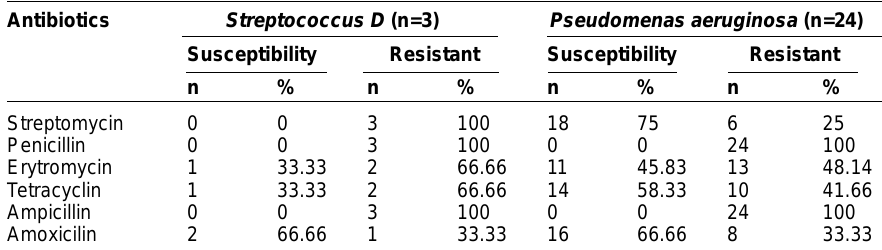
Table-1 (d): Antibiotic susceptibility of bacterial isolates (